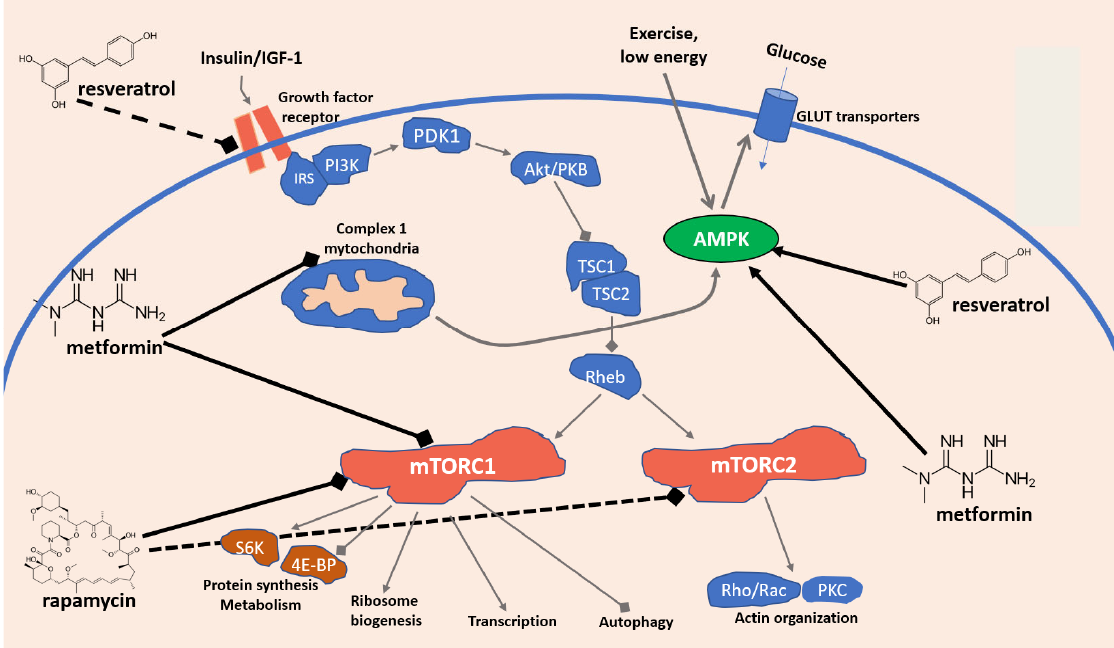
Figure 2. Simplified model of the mTOR signaling network in mammalian cells and antiaging mechanisms of resveratrol, metformin, and rapamycin.